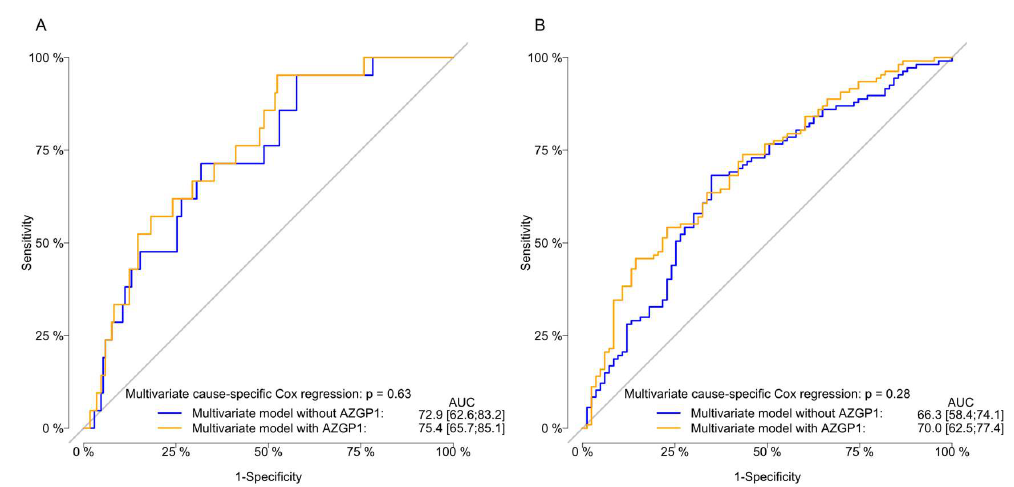
Figure 3. Evaluation of the of the model performance for the multivariate cause-specific Cox regression model for the risk of progression to castration-resistant prostate cancer (CRPC) with receiver-operating characteristic (ROC) curves stratified by AZGP1 expression and omitting the AZGP1 status. Area under the ROC curve (AUC) and p -values of the comparative tests are reported one ( A ) and five ( B ) years after the start of ADT.